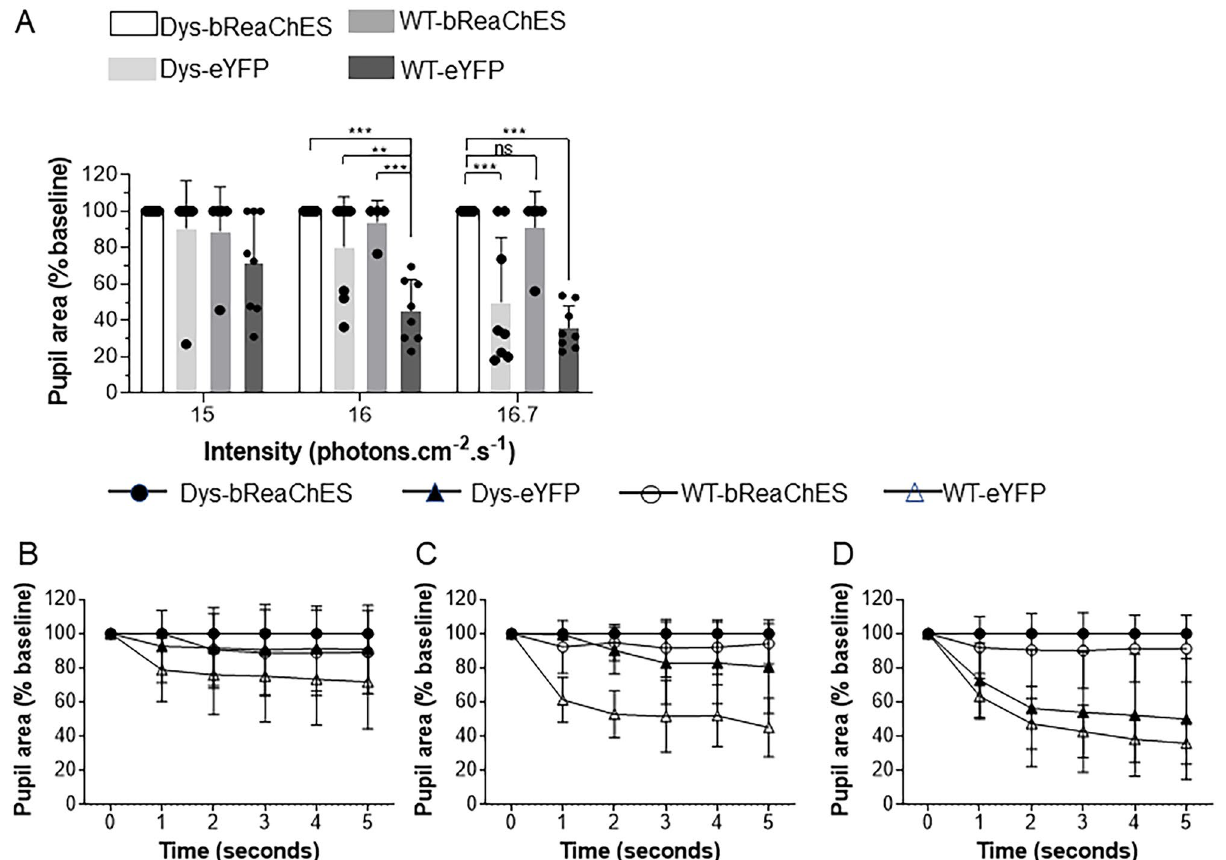
Figure 4. The pupil light reflex response in animals exposed to different intensities of 590 nm light stimulation 10 months after treatment. ( A ) Wild-type (WT) and dystrophic (Dys) animals treated with control vector showed constriction at all levels of stimulation, with the largest proportion of animals responded to the highest level of light stimulus following 5 s of light exposure. The percent pupil size over a 5-s period following exposure to different light intensities ranging from 1.49 ( B ), 15.9 ( C ), 16.6 ( D ) log photons cm −2 s −1 . (N = 9 bReaChES- injected dys mice, N = 8 control-injected dys mice, N = 5 bReaChES-injected WT mice and N = 8 control- injected WT mice) Error bars indicate ± SD. * p < 0.05, ** p < 0.001, *** p < 0.001 one-way ANOVA with one-sided Dunnett’s post hoc